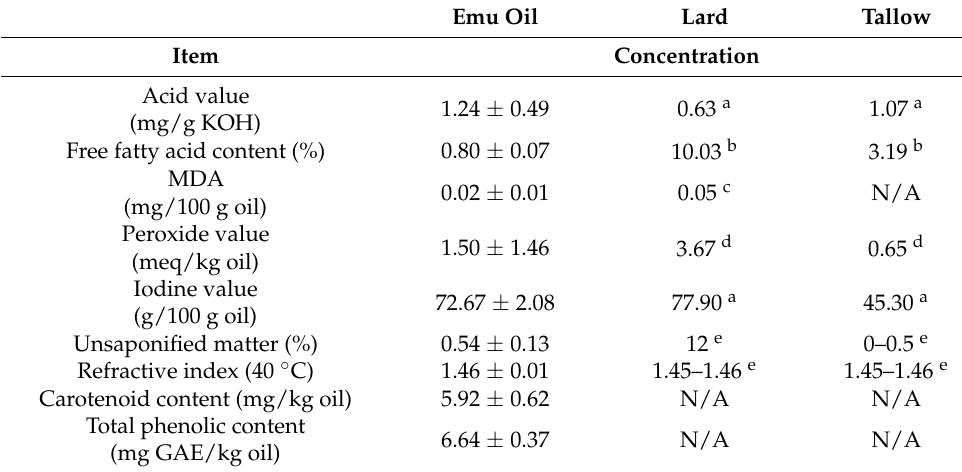
Table 1. Physicochemical properties of emu oil.